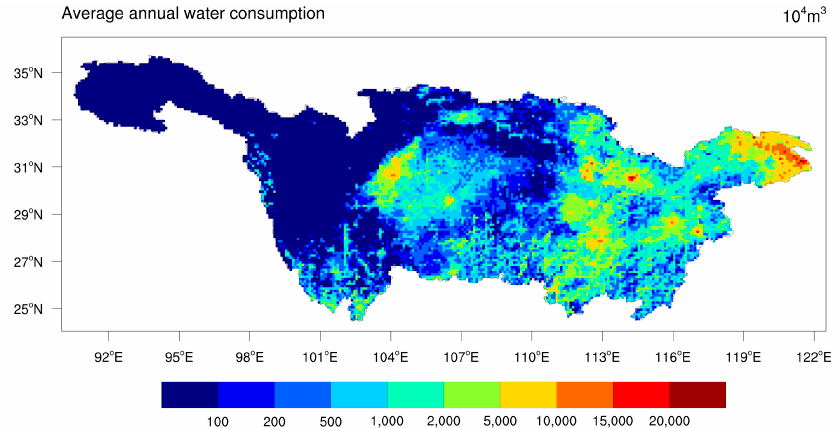
Figure 3. Spatial distribution of average annual water consumption in the Yangtze River Basin.